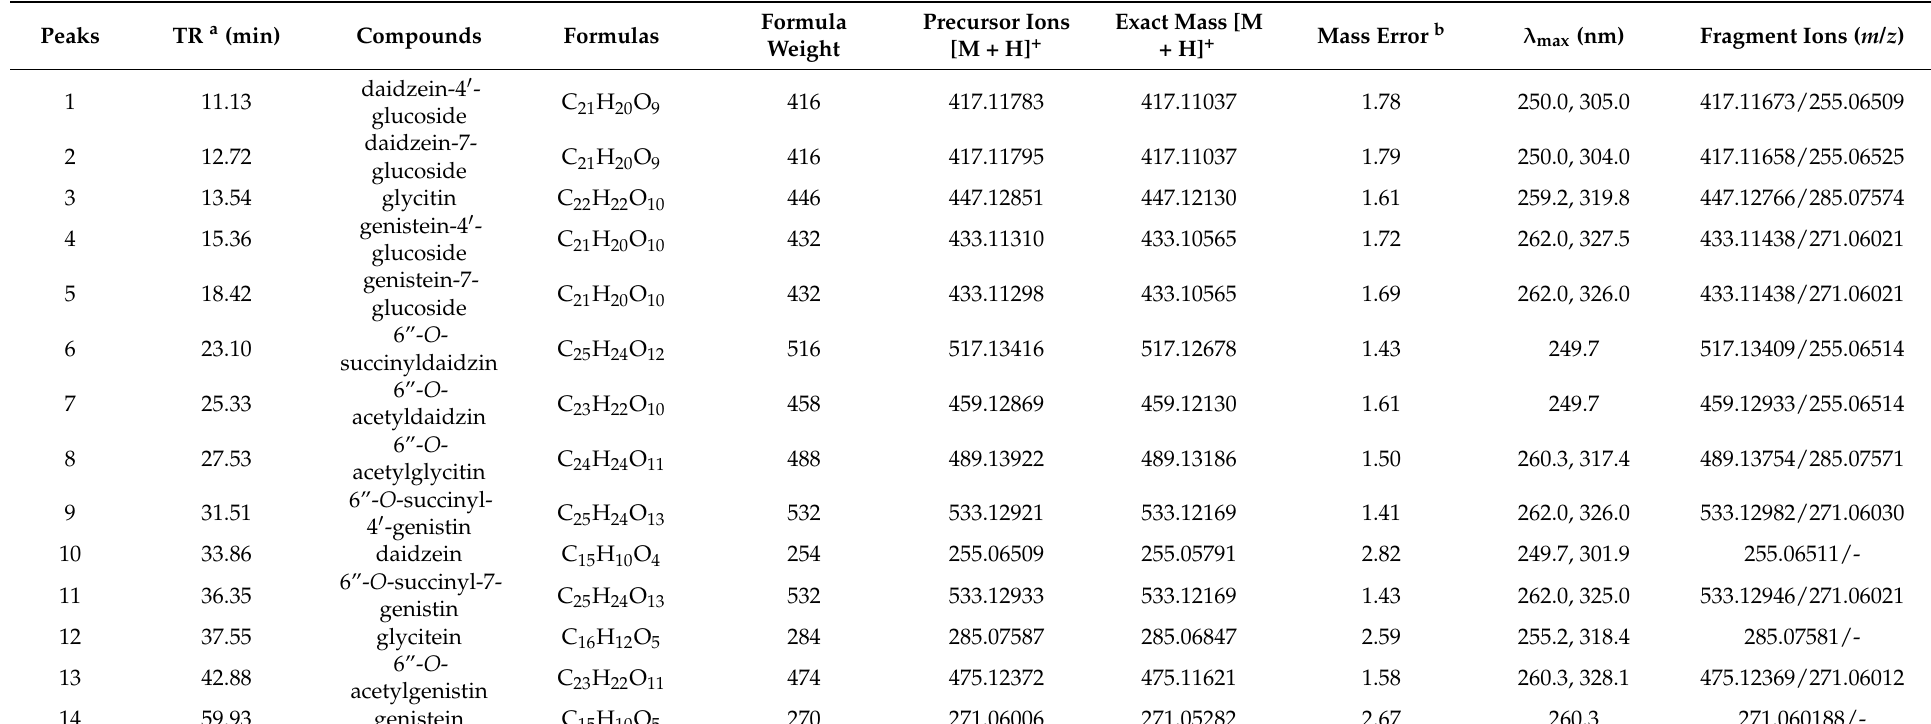
Table 2. UPLC-ESI-MS/MS analysis of isoflavone sample extracted from